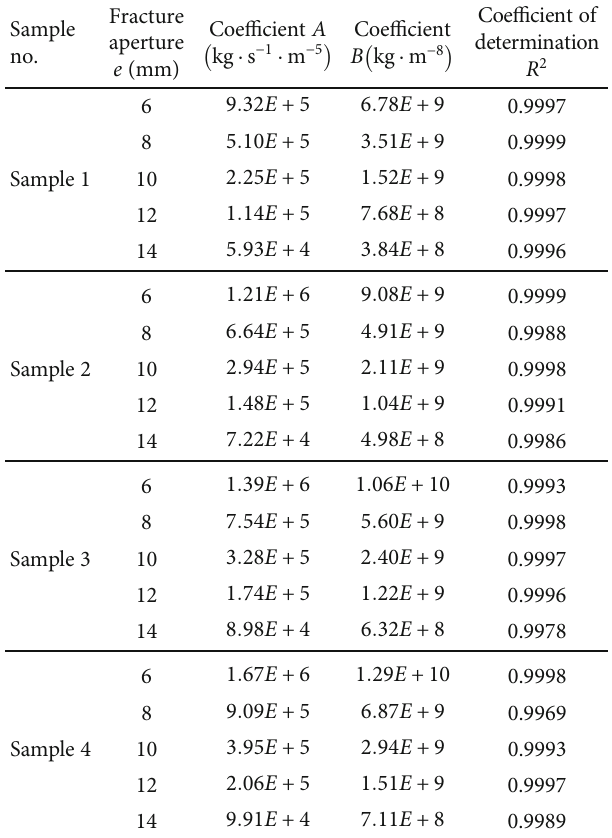
Figure 12: Fitted pressure gradient versus fl ow rate curves under various fracture apertures. Table 2: Summary of the fi tted coe ffi cients A , B of the Forchheimer equation.